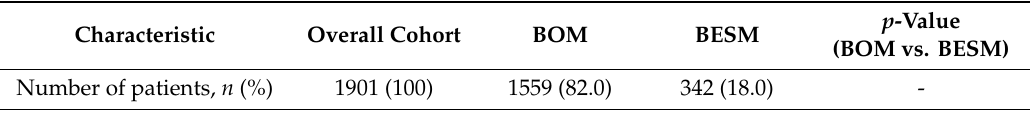
Table 1. Patient demographic / clinicopathological characteristics and type of concomitant treatment according to metastatic